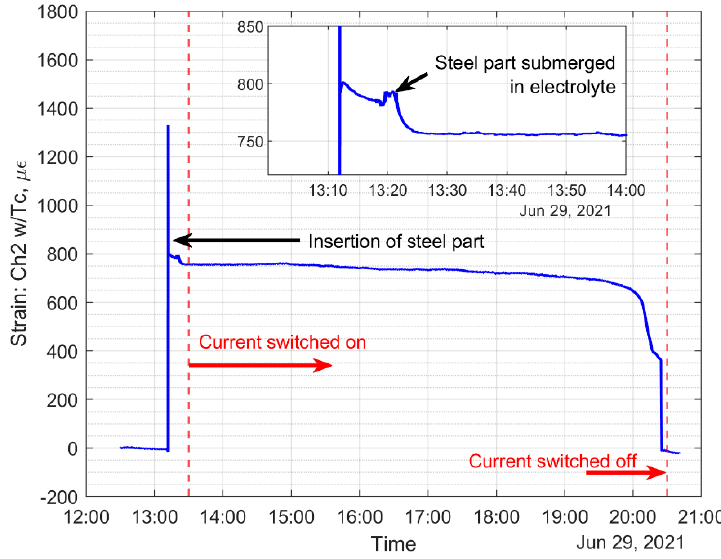
Figure 20. Timeline of the experiment, current switched on at 13:30, after strain stabilized from immersion into electrolyte.